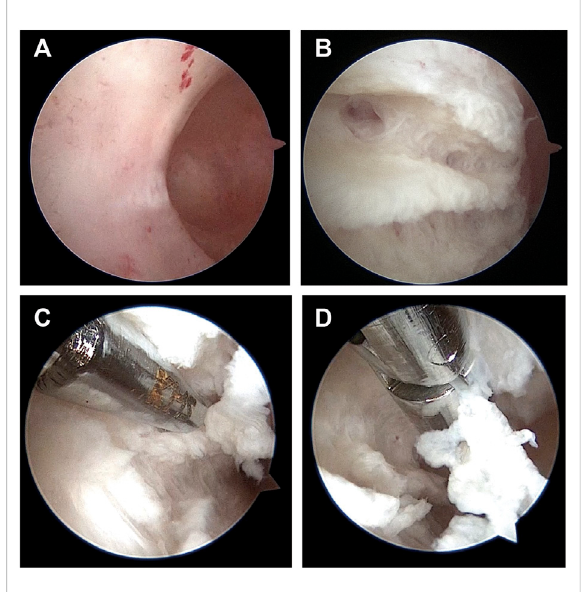
FIGURE 1 Scar tissue under hysteroscopy in patients with intrauterine adhesions. (A) . Scar tissue surface of inner wall of uterine cavity. (B) . Scar tissue image after cutting with scissors. (C) . Using scissors to cut scar tissue. (D) . Using forceps to clip scar tissue out of the uterine